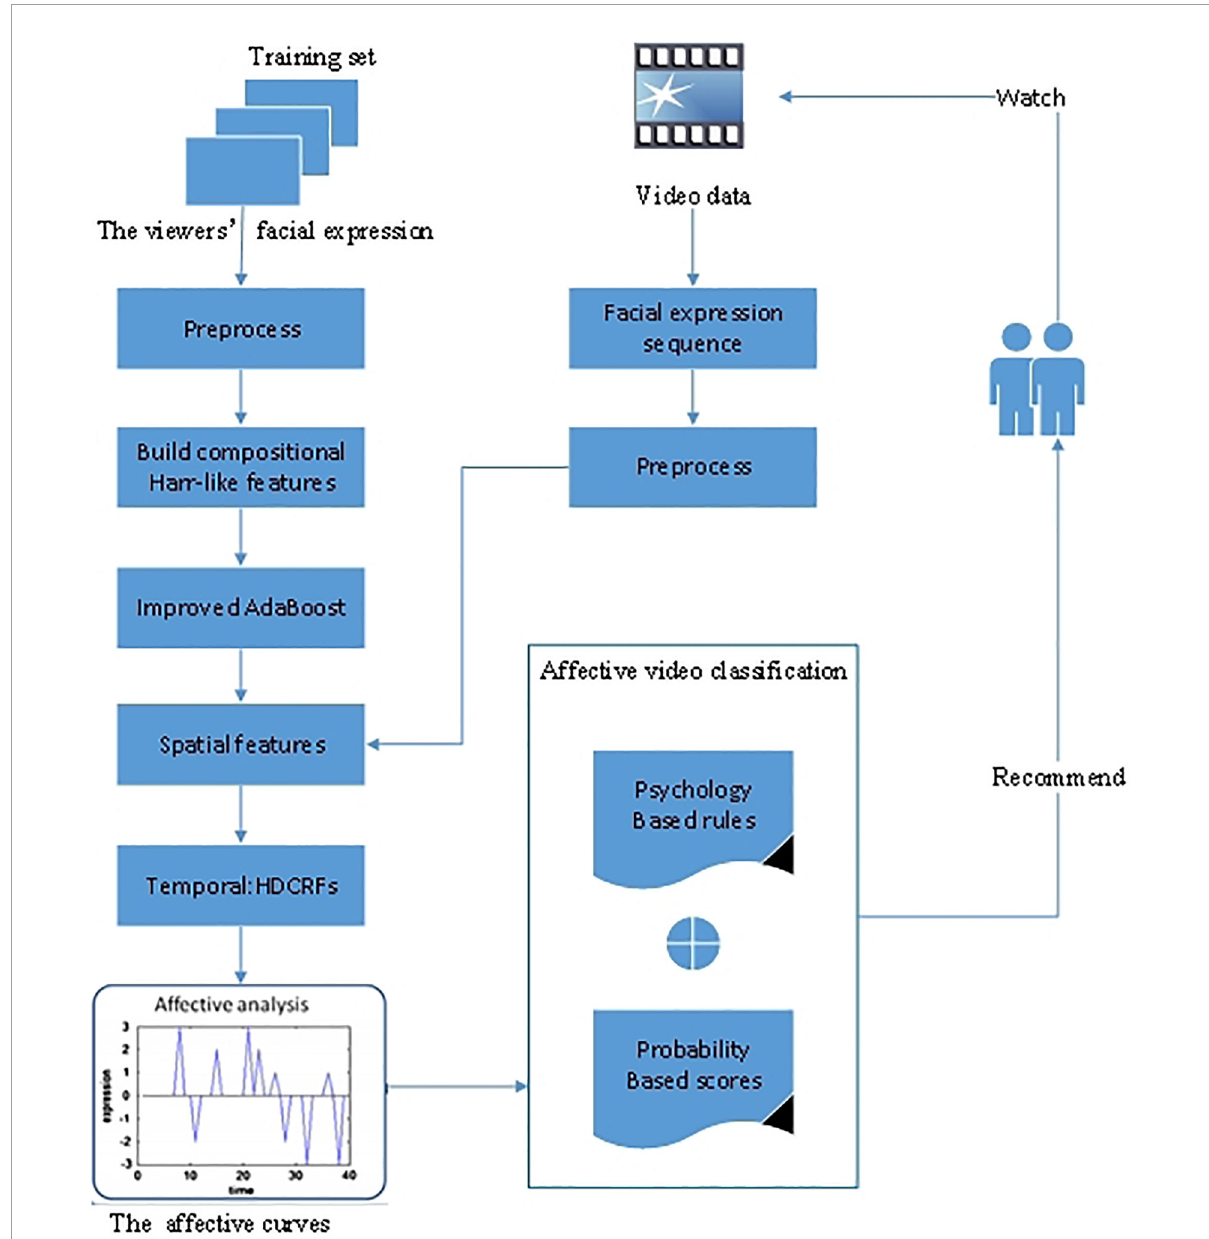
FIGURE3 The framework of the improved AdaBoost learning algorithm (Zhao et al.,